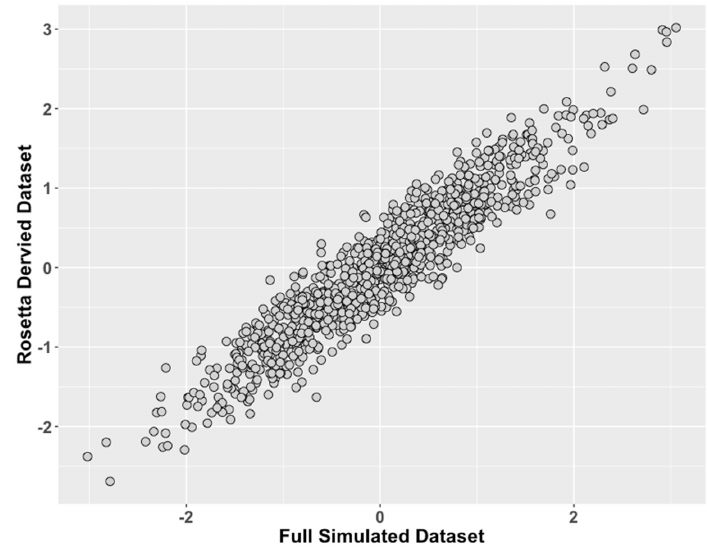
Figure 3. Study 2: Data Modeled After a Clinical Behavioral Dataset, Comparison of ROSETTA scores versus scores from complete data. We compared values of the latent traits from the full dataset condition (ground truth) on the x-axis to the incomplete matched datasets derived with ROSETTA on the y-axis. Table 4. Study 2: Observed Correlations between ROSETTA and Full Data. Table 3. Study 1: Expected Correlations Between Measures as Determined by Full Data.